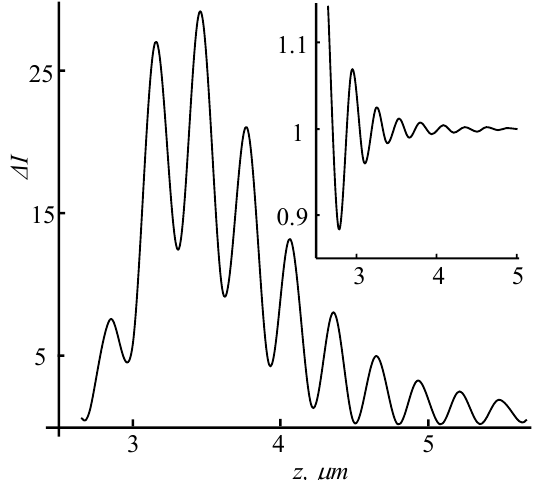
Figure 3: Backscattering intensity perturbation caused by the 60 nm gold particle and core/shell microsphere AB . z is the distance between the surface of sphere A and center of the particle. Inset: same for single sphere A .